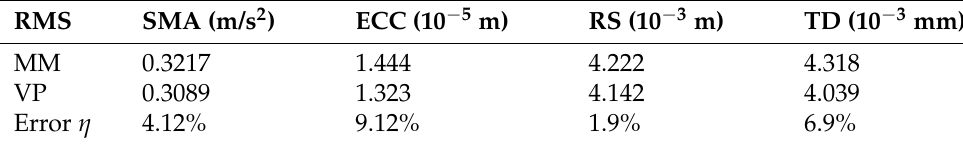
Figure 13. Responses of the MM and the VP: ( a ) time response of the SMA; ( b ) frequency response of the SMA; ( c ) time response of the ECC; ( d ) frequency response of the ECC. Table 4. Modeling errors between the mathematical model and the VP